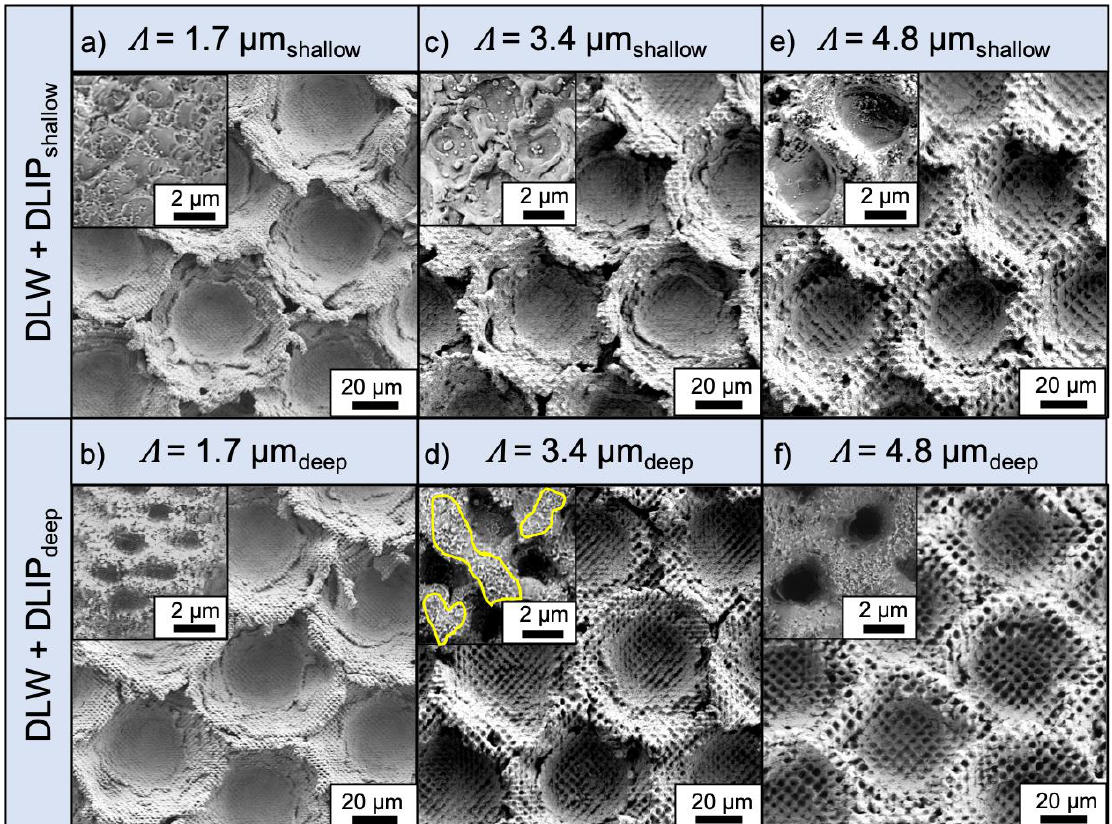
Figure 3. SEM images of the multi-scale textures resulting from DLW combined with a shallow DLIP pattern with a spatial period of 1.7 µm ( a ), 3.4 µm ( b ), and 4.8 µm ( c ) as well as the combination of DLW and deep DLIP pattern with the same spatial periods ( d, e, f ), respectively. For the DLW processing 20 pulses were used, each with a laser fluence of 6.56 J/cm 2 . Details about the number of pulses and the laser fluence for the DLIP processing are given in Table 1